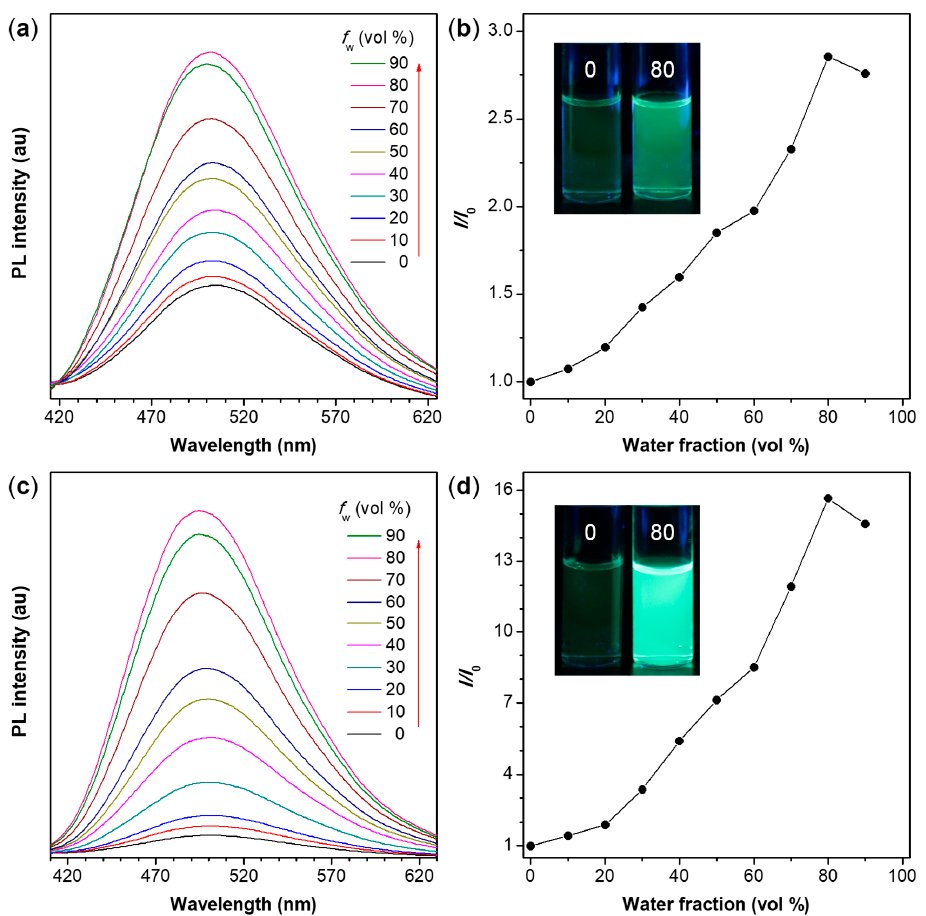
Figure 5. ( a , c ) PL spectra of ( a ) P 1 / 2 -I and ( c ) P 1 / 2 -II in THF and THF/water mixtures with different water fractions ( f w ). ( b , d ) Plot of relative emission intensity ( I / I 0 ) versus the composition of the aqueous mixture of ( b ) P 1 / 2 -I and ( d ) P 1 / 2 -II, where I = peak intensity and I 0 = peak intensity in pure THF solution. Inset: fluorescent photographs of P 1 / 2 -I and P 1 / 2 -II in pure THF solution and in THF/water mixture with f w of 80% taken under 365 nm UV illumination from a hand-held UV lamp. Solution concentration: 10 μ M; excitation wavelength: 350 nm.